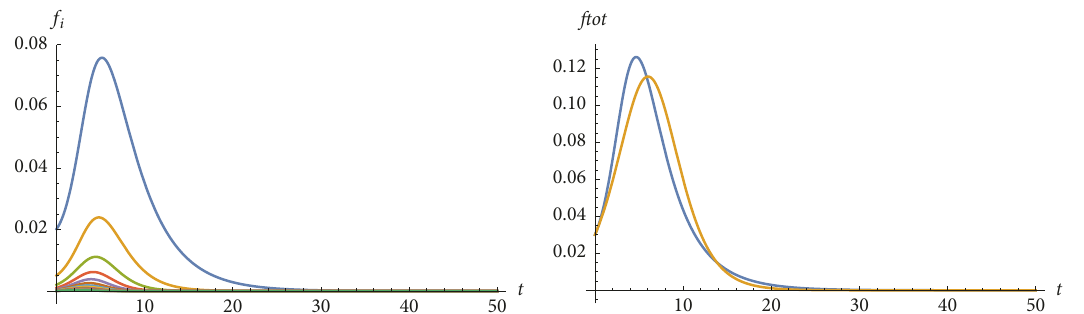
Figure 1: Left panel : fraction 𝑓 𝑖 of new adoptions per unit time in the “link class 𝑖 ” (the subset of all individuals having 𝑖 links), as a function of time, in the Bass innovation diffusion model on a BA network. The parameter 𝛽 of the network (number of child nodes in the preferential attachment scheme) is 𝛽 = 1 . The maximum number of links in this example is 𝑛 = 15 , while in the comprehensive numerical solutions, whose results are summarized in Figure 2, it is 𝑛 = 100 . The adoption peak occurs later for the least connected (and most populated) class with 𝑖 = 1 . Right panel : cumulative new adoptions 𝑓 𝑡𝑜𝑡 = ∑ 𝑛 𝑖=1 𝑓 𝑖 per unit time, as a function of time, compared with the same quantity for the homogeneous Bass model without an underlying network. The peak of the homogeneous Bass model is slightly lower and shifted to the right. For the values of the model parameters 𝑝 and 𝑞 and the measuring unit of time, see Figure 2.